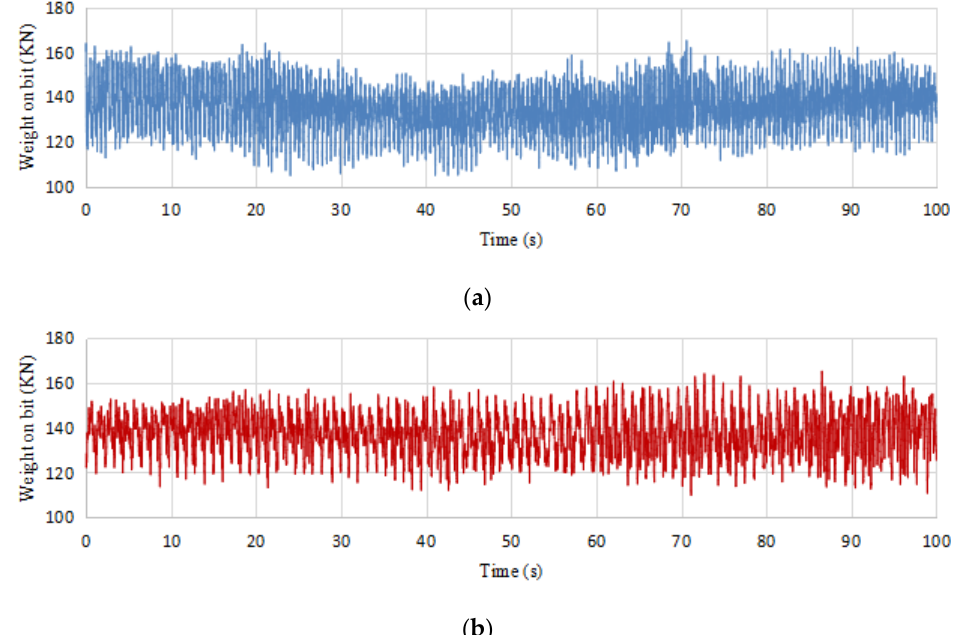
Figure 7. Compare measured WOB and calculated WOB. ( a ) The measured WOB. ( b ) The calculated WOB.